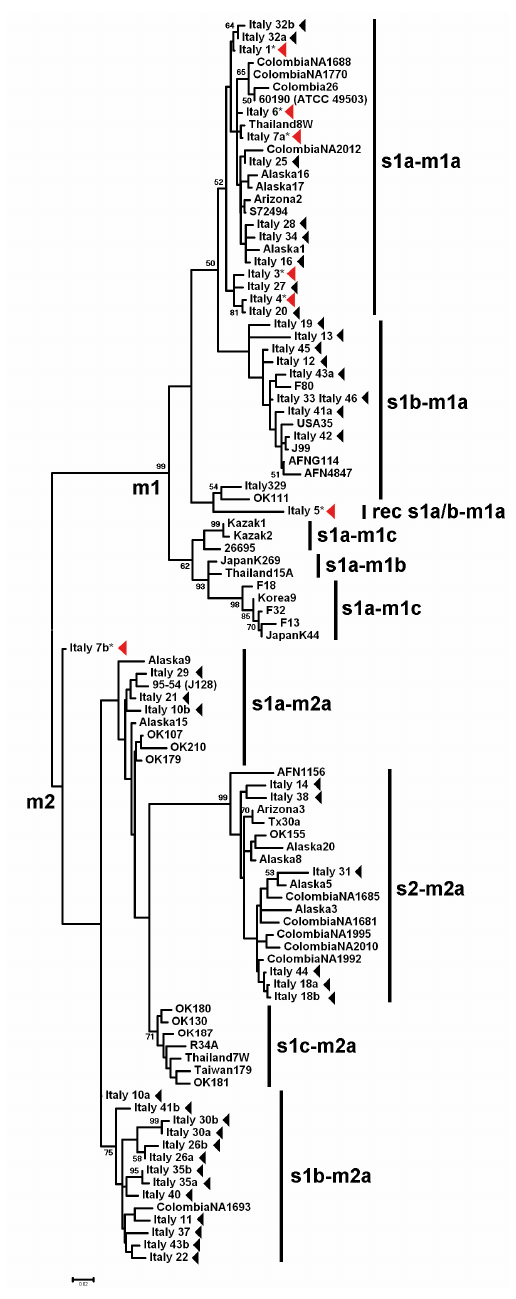
Figure 1. Phylogenetic tree of 100 vacA s and m Helicobacter pylori sequences. The 45 sequences obtained in this study are indicated by arrowheads; asterisks and red arrowheads highlight association with gastric intraepithelial neoplasia. Other sequences, labeled according to strain designation, are from GenBank.